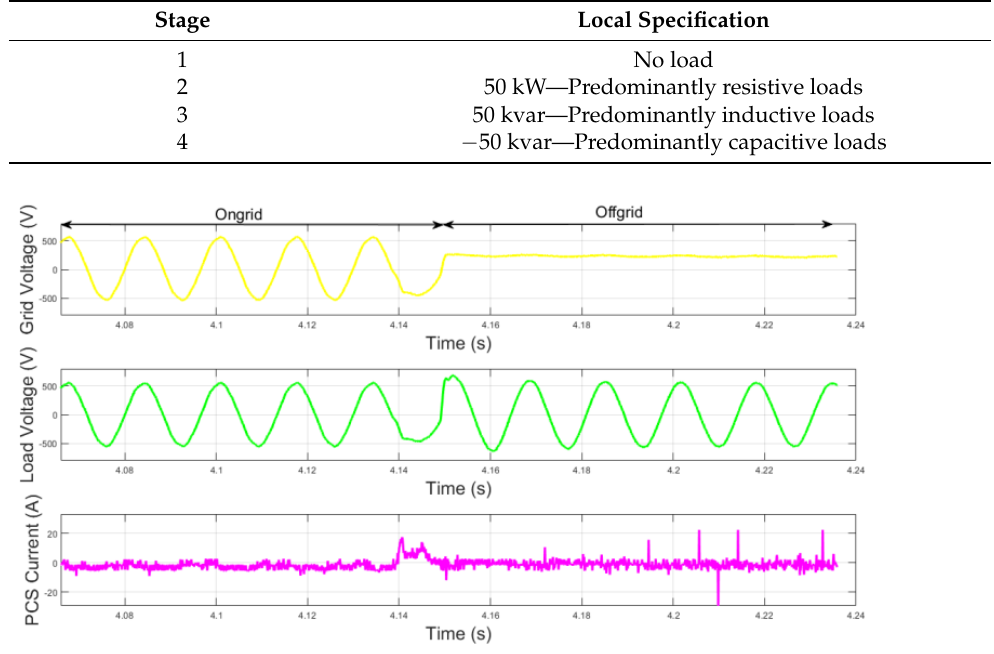
Figure 6. Stage 1: No-load backup — signal captured by the oscilloscope at the time the backup was simulated.